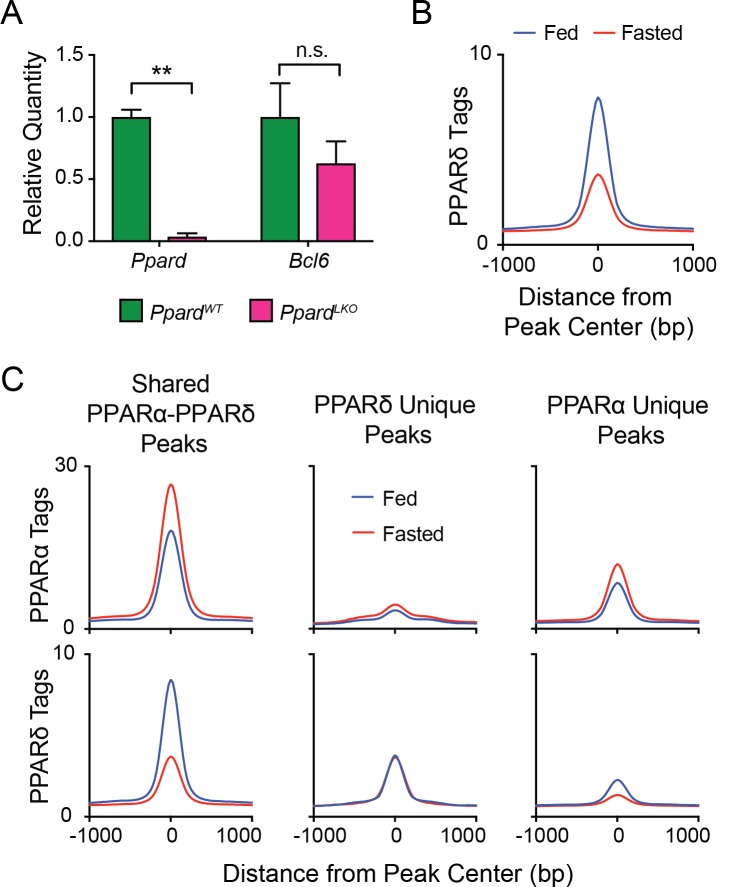
PPARα and PPARδ compete for binding at shared sites.(A) qPCR gene expression of Ppard and Bcl6 genes in control (PpardWT) and PpardLKO mouse livers. N = 2 per group. (B) PPARδ tag densities in fed or fasted mouse livers at all PPARδ peaks. N = 3 per group. (C) PPARα (top panel) and PPARδ (bottom panel) tag densities in fed and fasted livers at PPARα-PPARδ overlapping peaks (left panel), PPARδ unique peaks (middle panel) or PPARα unique peaks (right panel). N = 3 per group. A two-tailed Student’s t-test assuming equal variance was used to compare mean values between two groups. Data are represented as mean ±SEM. ∗p<0.05, ∗∗p<0.01, ∗∗∗p<0.001.